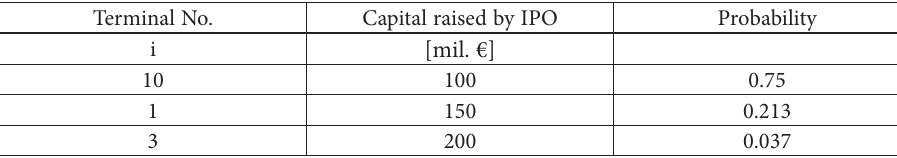
Table 11. Probabilities of the capital raised by IPO and the mean value Terminal